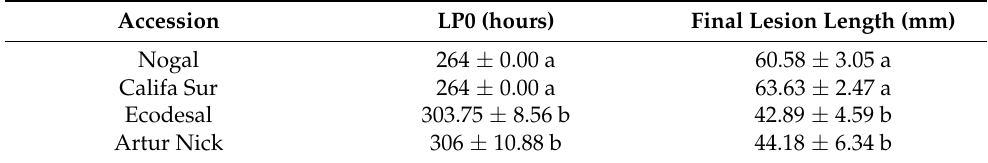
Table 2. Macroscopic components of disease progression of P. striiformis infection in four selected bread wheat accessions 1